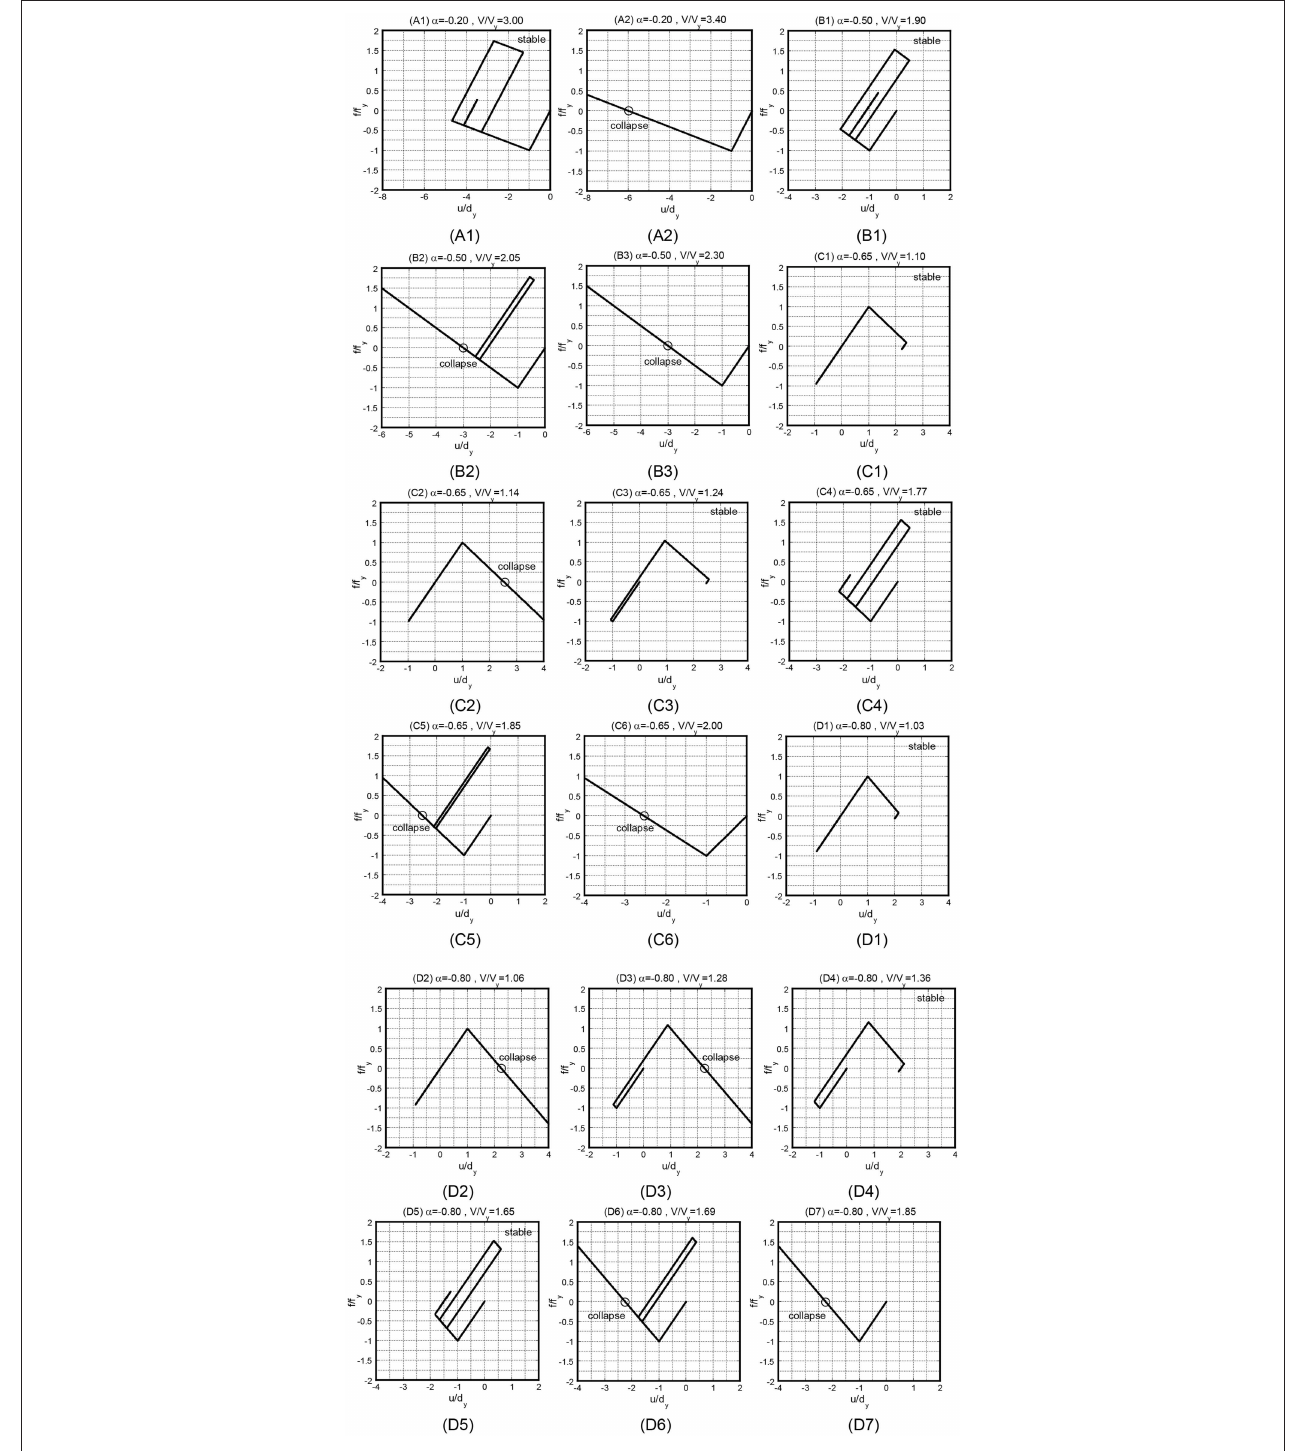
FIGURE 8 | Restoring force-deformation relation of 18 stability or collapse cases (damping ratio h wave which can represent the main-part of near-fault ground motions through the comparison with the collapse velocity level of the one-cycle sinusoidal wave. The following relation